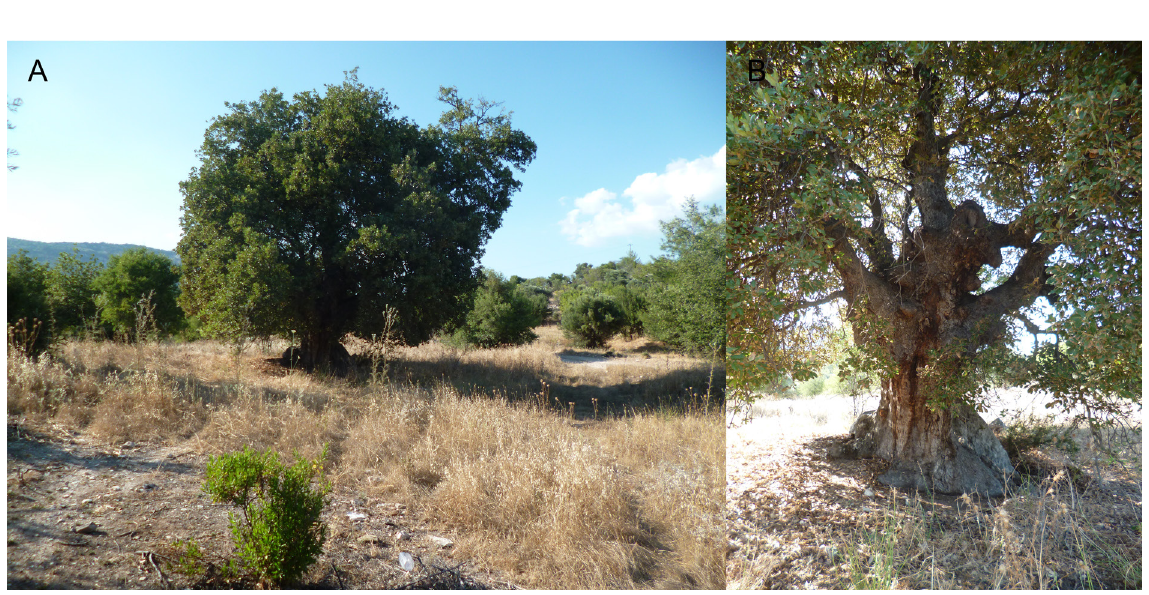
Fig. 4. A . Habitat of Brachypsectra sp. from Cyprus, Vretsia. B . Quercus infectoria